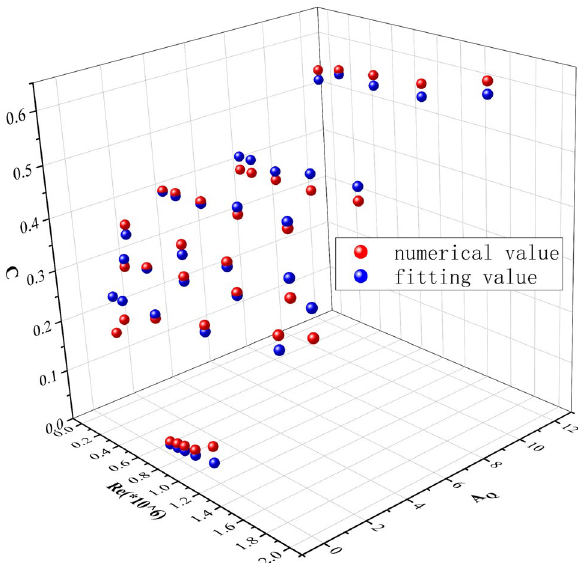
Figure 10. Comparison of simulated and fitted values when L = 14